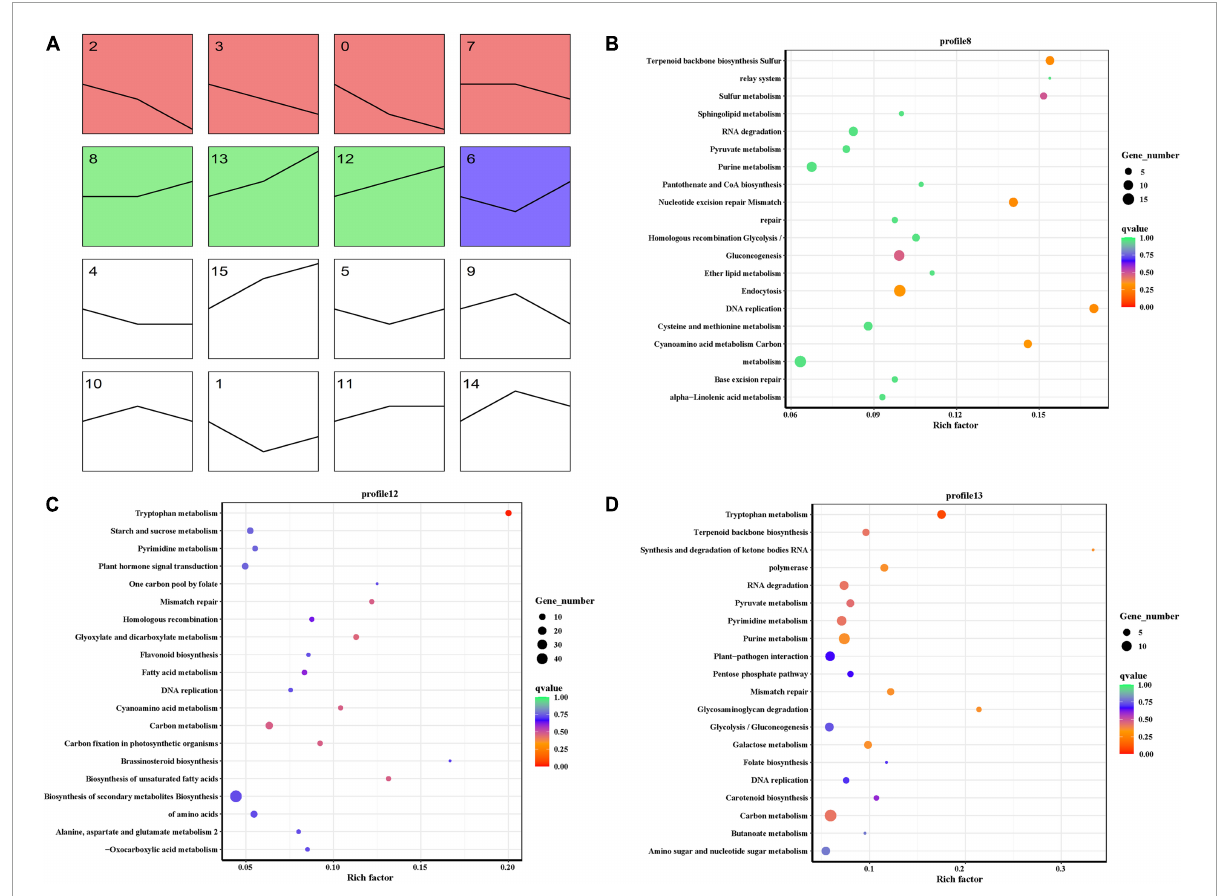
FIGURE8 Time series analysis of RNA-seq. (A) Overall rendering of gene clustering. (B) Profile 8 KEGG pathway enrichment scatterplot. (C) Profile 12 KEGG pathway enrichment scatterplot. (D) Profile 13 KEGG pathway enrichment